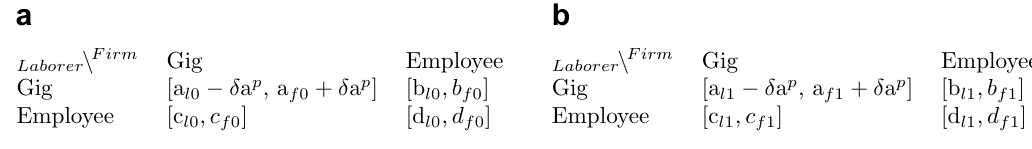
Figure 3: Lenient Policy, Matrix Operation Figure 14. Lenient policy, matrix operation. ( a ) Lenient ordinance, n = 0. ( b ) Lenient ordinance, n = 1.